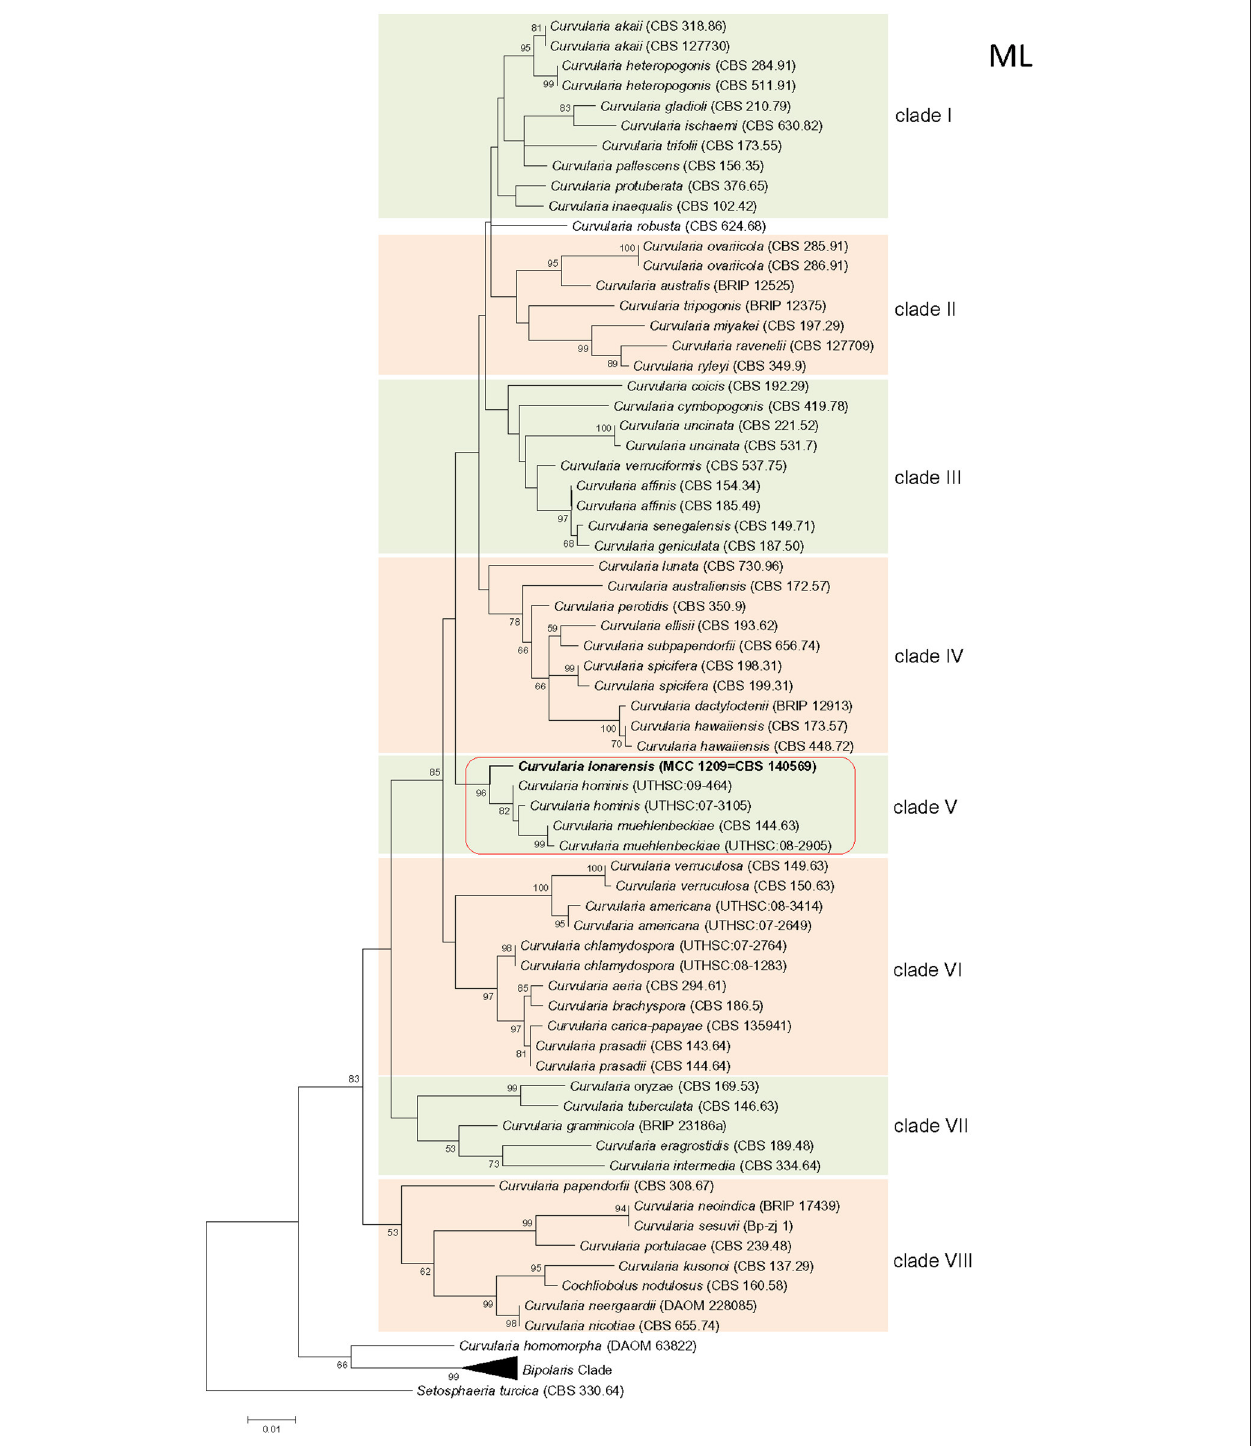
FIGURE 3 | Maximum Likelihood (ML) tree of the Curvularia strains studied. Bootstrap support of branches indicated on the node was obtained using 1000 replicates. Only statistically significant bootstrap values ( ≥ 50%) are indicated. Branch lengths are indicated as 0.01 substitutions per positions according to the scale bar underneath the tree. Number on right side of species name denotes the strain number/ culture collection accession number. Number in parentheses denotes accession number of the sequence deposited to online database.